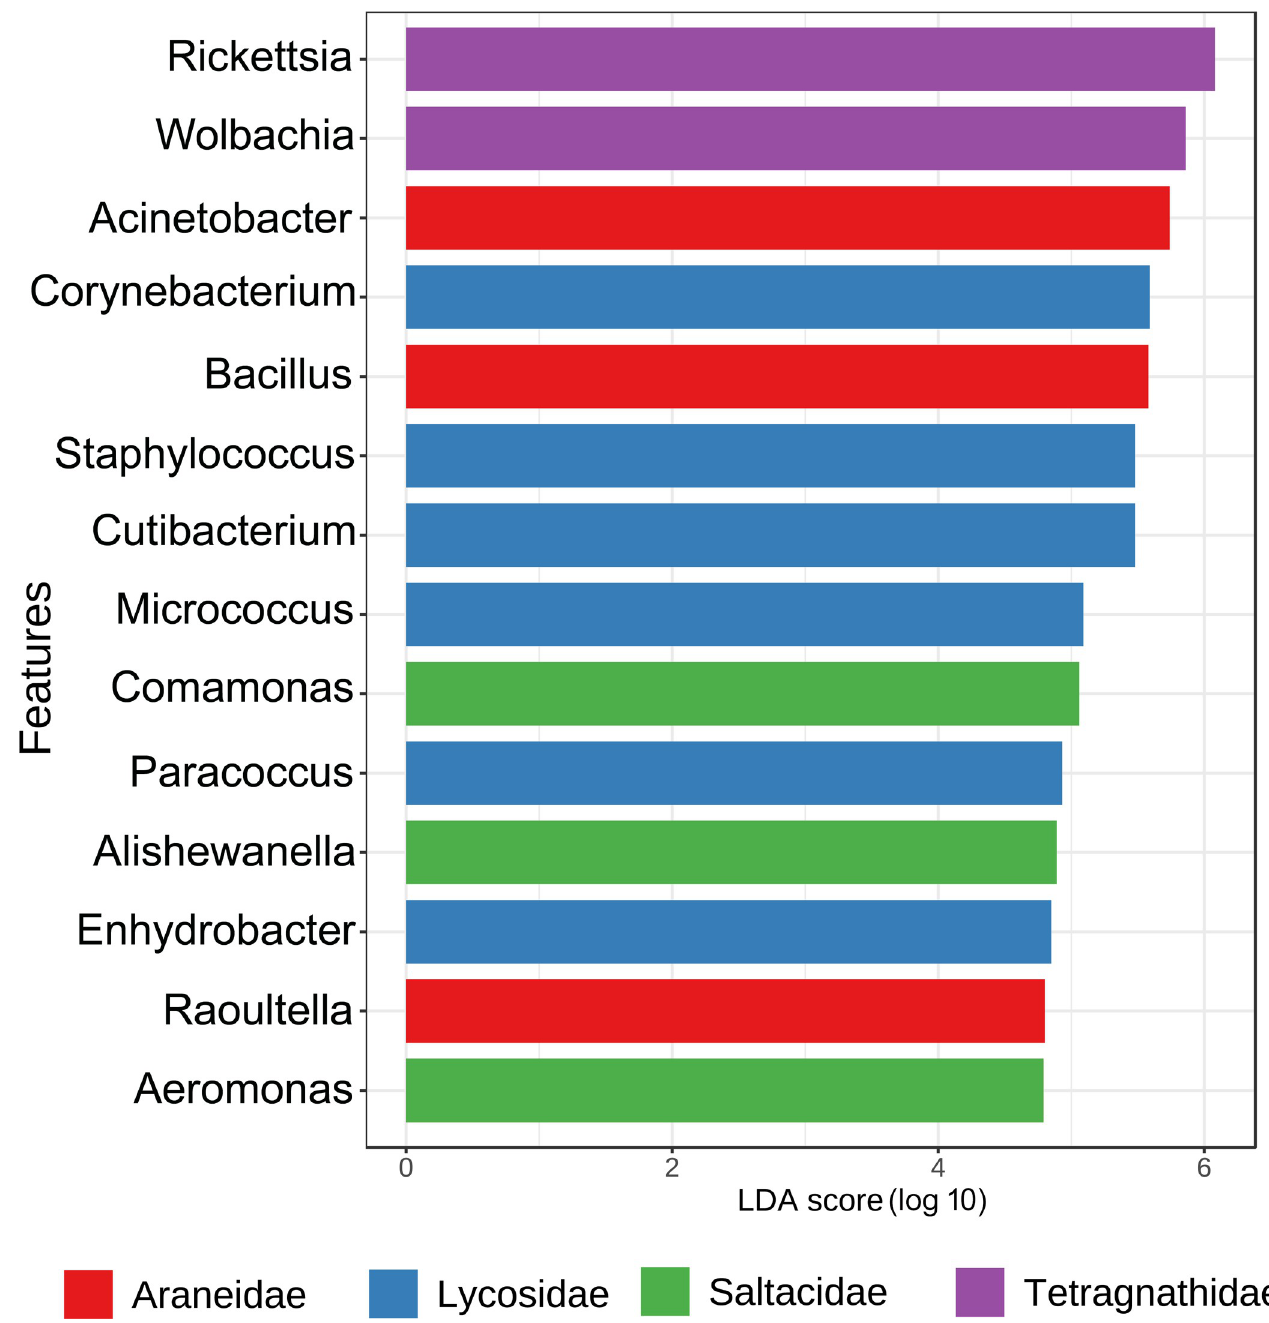
Fig 6. LDA results based on genus level in four spider families. diversity of the Araneidae family in comparison with other spider families. The genera Coryne- bacterium , Staphyloccocus , Cutibacterium , Micrococcus , Paracoccus , and Enhydrobacter were found in the Lycosidae family and are distinct from other spider families. The genera Coma- monas , Alishewanella , and Aeromonas constituted the distinguishing features of the Salticidae family.